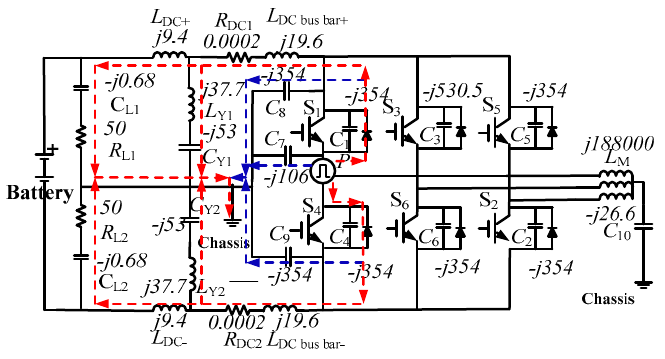
Figure 9. CM interference propagation path at 30 MHz.